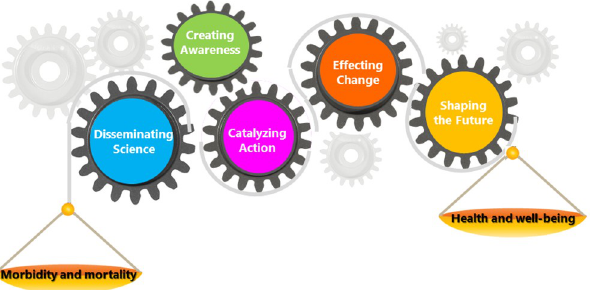
Fig 1: The Science Impact Framework, illustrates the SIF with five domains of scientific impact that express the scope and type of influence generated by the scientific undertaking. The degree of impact is not necessarily a linear sequence of progression through the five domains; therefore, events captured may not be reflected in every domain and may not occur chronologically. The model also portrays the complexity of the measurement environ- ment with other influences beyond the ones described by the domains of the SIF. For exam- ple, there may be other influences that may or may not work synergistically with the desired influence for the work under consideration. Thus, impacting the ability to achieve desired outcome positively or negatively. Our model uses both quantitative and qualitative